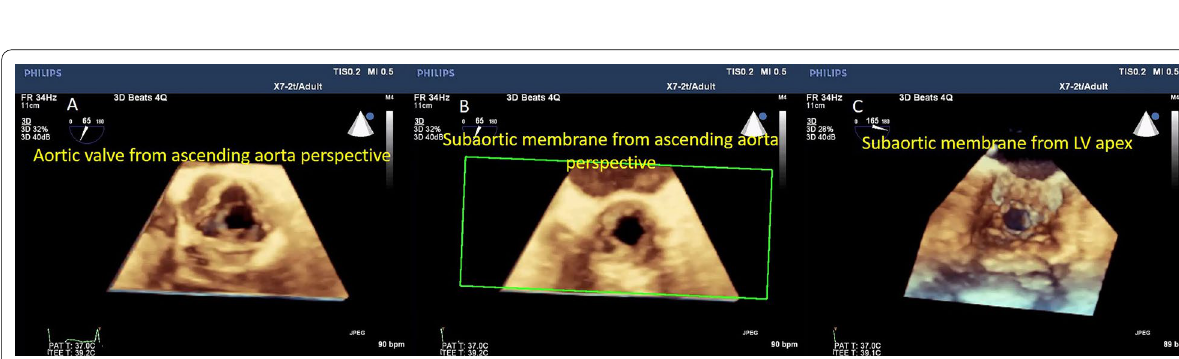
Fig. 5 3D zoomed mode, "en‑face" view of the aortic valve (panel A) and subaortic membrane from the ascending aorta perspective (panel B) and subaortic membrane from LV apex (panel C)